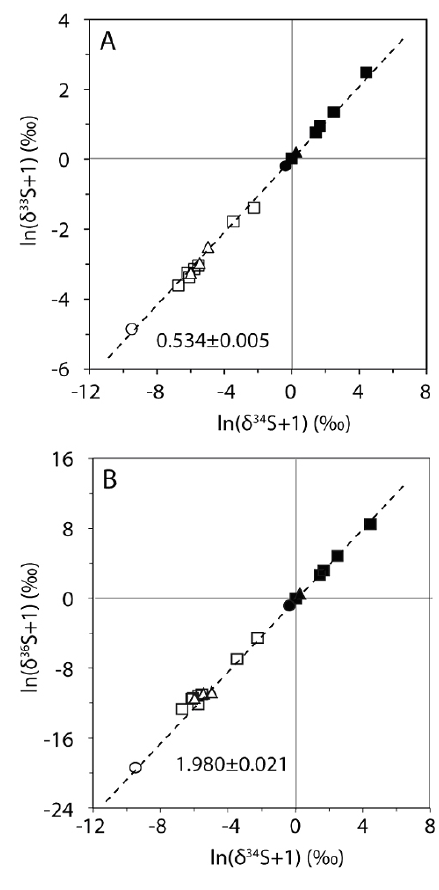
Fig. 1. Sulfur isotopic compositions of residual OCS (filled sym- bols) and product S 0 (open symbols) relative to initial OCS after photolysis of OCS. Square, triangle, and circle symbols are for pure OCS, OCS with N 2 , and OCS with λ> 285nm photolysis experi- ments,